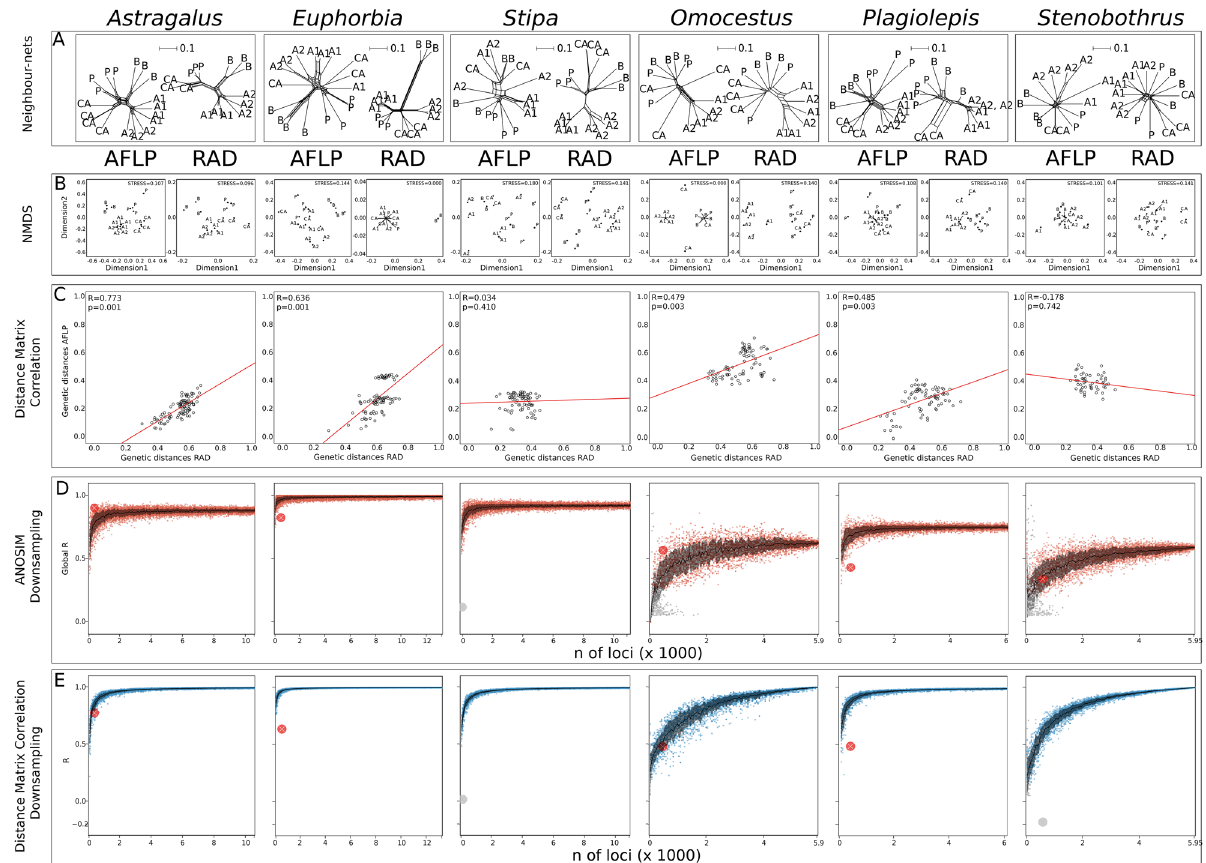
Figure 2. Comparative analyses for the six study species based on amplified fragment length polymorphism (AFLP) and restriction site-associated DNA (RADseq) sequencing data Abbreviations in A-B reflect the geographic origin of the sample: A1 = Western Alps, A2 = Eastern Alps, B = southeastern Balkan, CA = Central Asia, P = Pannonia. ( A ) NeighborNets inferred from AFLP data and RADseq data. ( B ) Ordination of AFLP and RADseq data via non-metric multidimensional scaling (NMDS). ( C ) Correlation plots of AFLP and RADseq derived distance matrices. Mantel R and corresponding significance levels are shown in the plot. ( D ) Global R values derived from analysis of similarity (ANOSIM) 79 of down-sampled RADseq matrices. Each point represents one randomly down-sampled observation; colored points are significant observations, grey points are non-significant. Larger points show calculations based on the number of available AFLP loci. ( E ) Correlation coefficient R calculated via Mantel matrix correlation of down-sampled RADseq matrices and the full RADseq matrix. Each point represents one randomly down-sampled observation; coloured points are significant observations, grey points are non-significant. Large red points show calculations based on the number of available AFLP